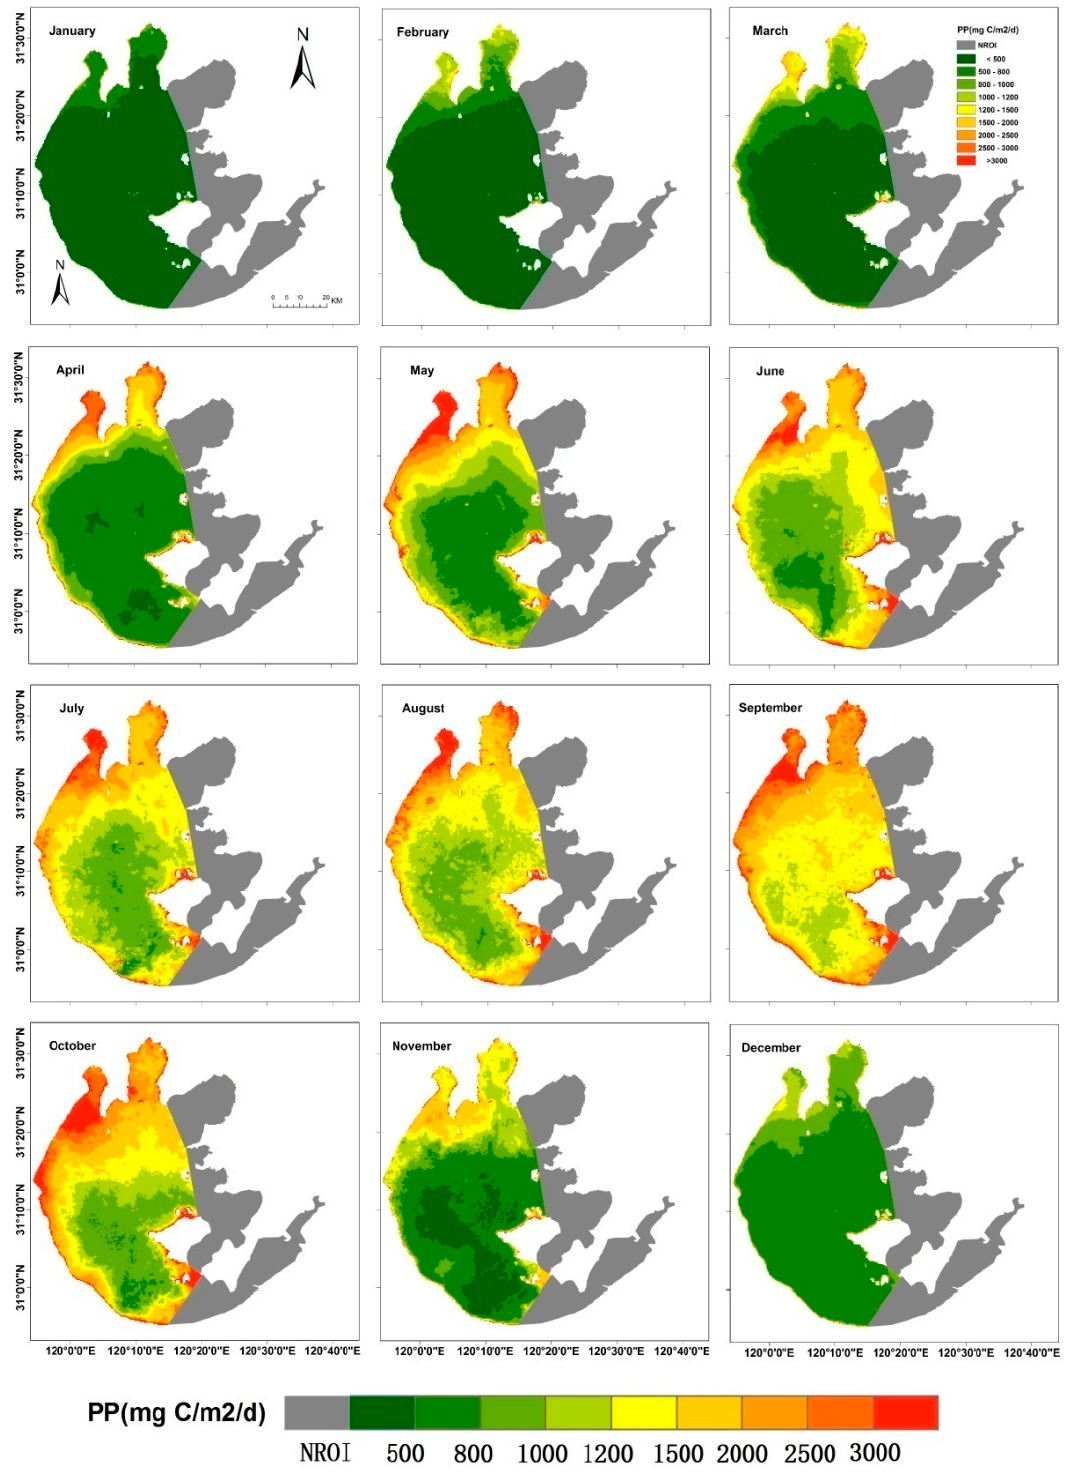
Figure 6. Monthly mean daily phytoplankton primary production of Lake Taihu from January to December.